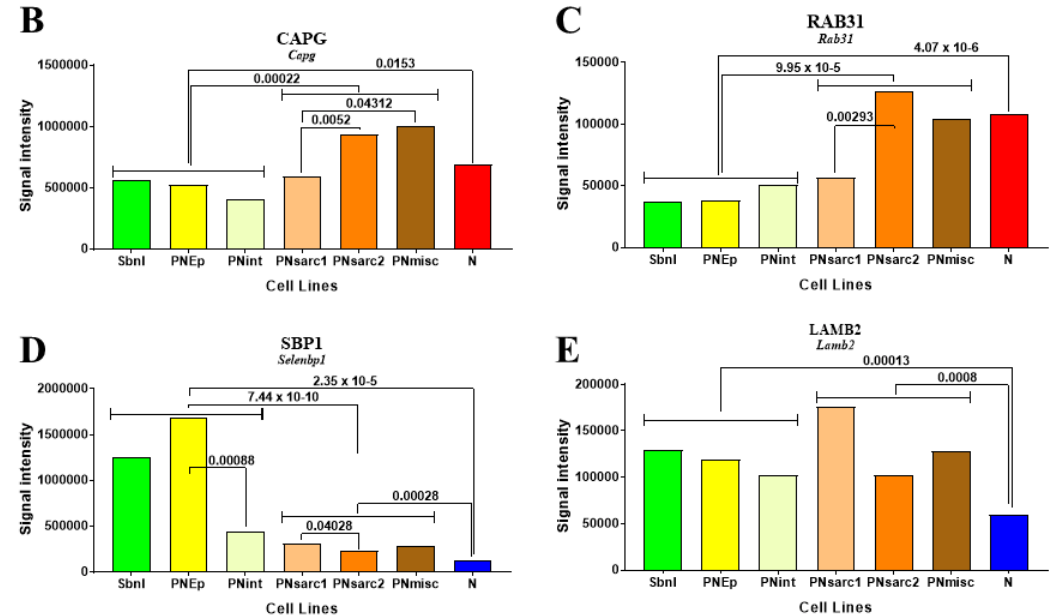
Figure 6. Biomarkers of human vs. rat MM and rat mesothelial cell carcinogenesis. ( A ), Diagram of the methodology used to identify biomarkers showing additional changes during the course of rat mesothelial cell carcinogenesis. For both CAPG ( B ) and RAB31 ( C ), a common rise in abundance was specifically observed in PNsarc2 vs. PNsarc1 and between the whole groups of preneoplastic cell lines with sarcomatoid vs. epithelioid morphology. ( D ), Evolution of abundance changes for SBP1. ( E ), Evolution of abundance changes for LAMB2.